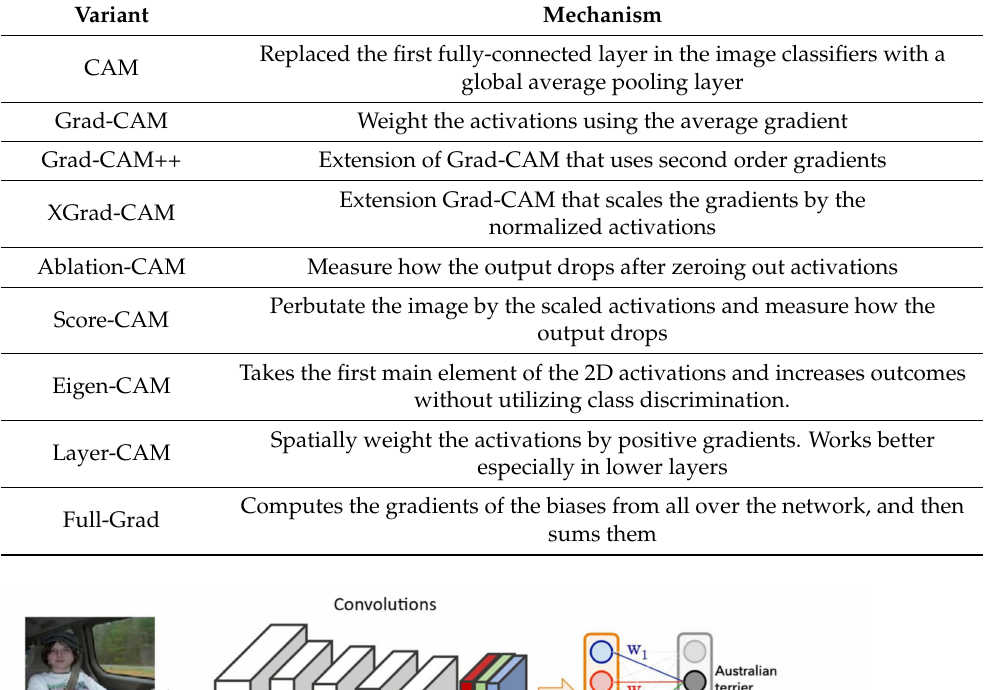
Table 5. Illustration of popular CAM Variants.